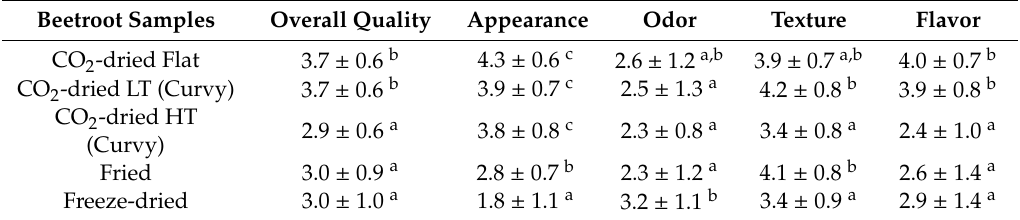
Table 3. Sensory quality scores 1 for dried beetroot